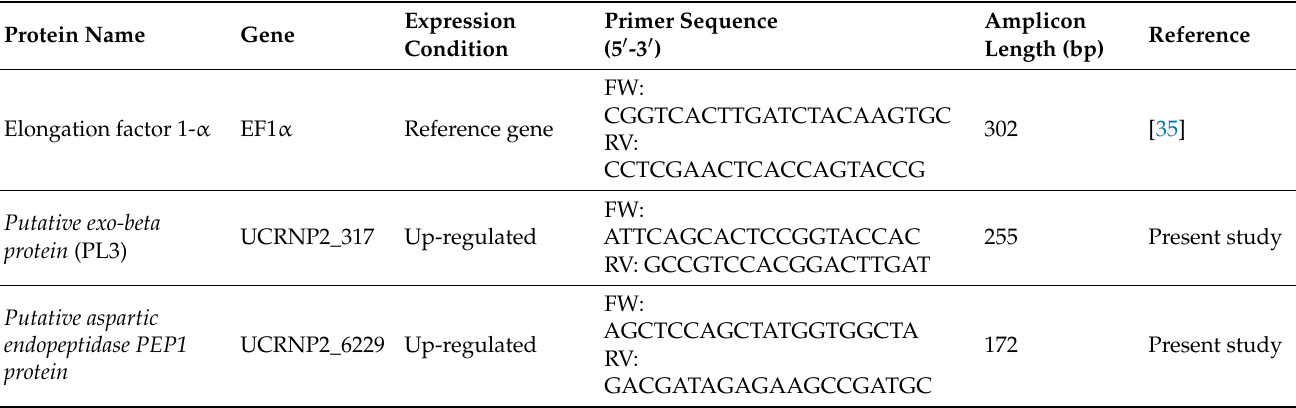
Table 1. Reference and target genes and respective